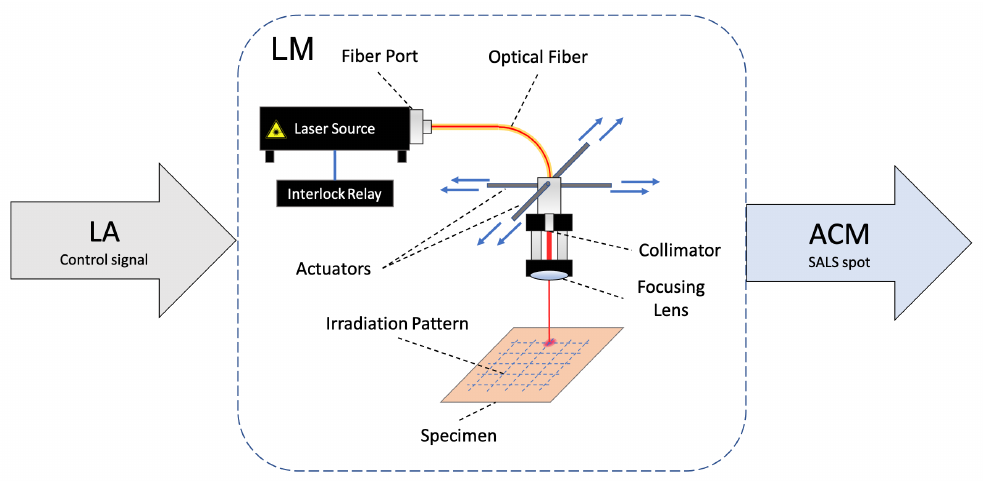
Figure 3. Laser module (LM) hardware components in communication with the laser application and acquisition/control